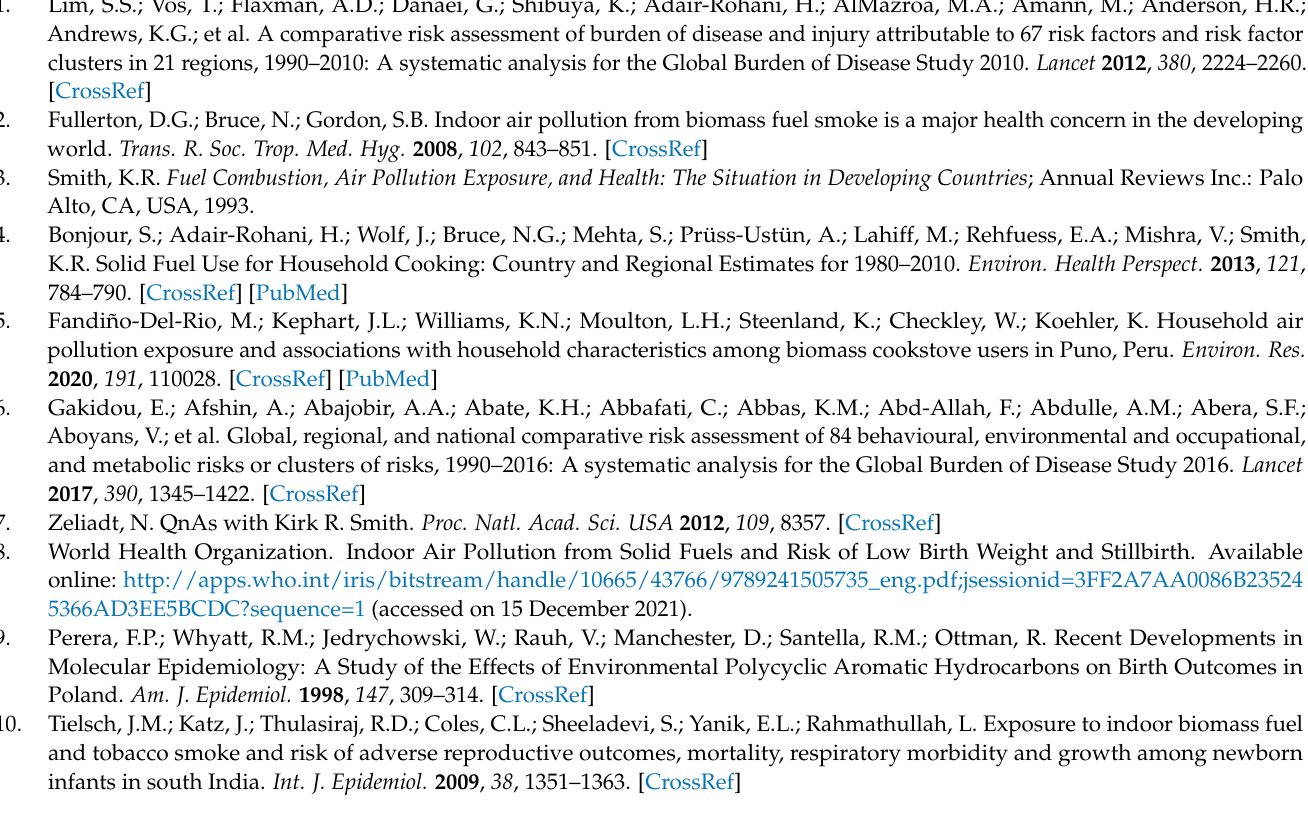
Table S2: Hourly average PM 2.5 concentrations corrected for background PM 2.5 levels. Figure S1: Location of rice mills and brick kilns within the study area that were in operation during the LPG cookstove intervention